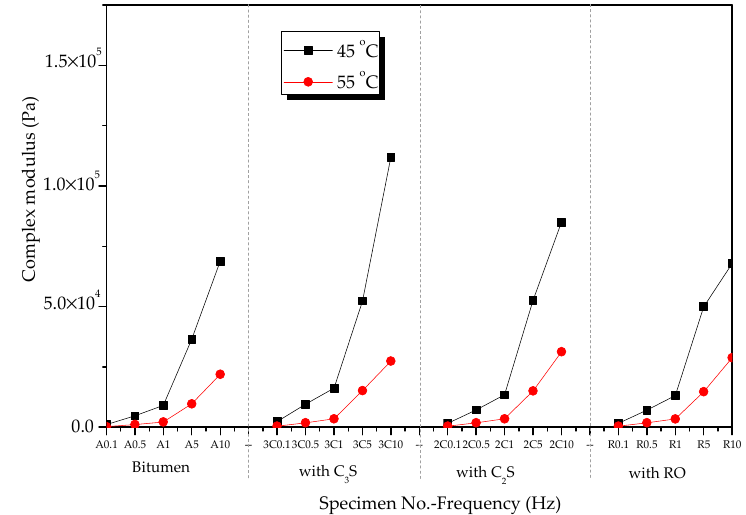
Figure 11. Complex shear modulus of mixtures of bitumen–mineral components of steel slag at different temperatures.